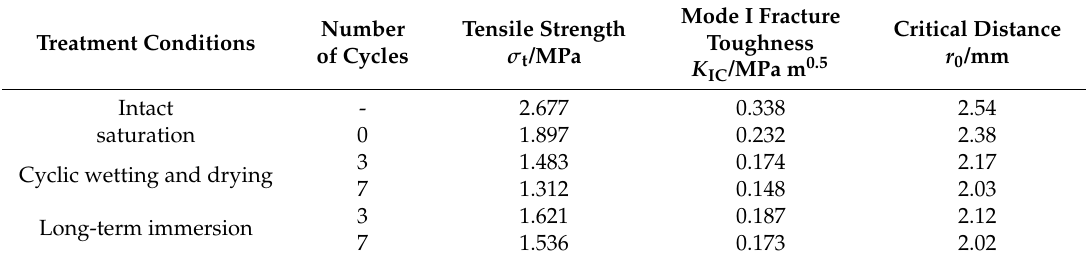
Table 2. The values of critical distance r 0 for sandstone under different water–rock interaction conditions. Treatment